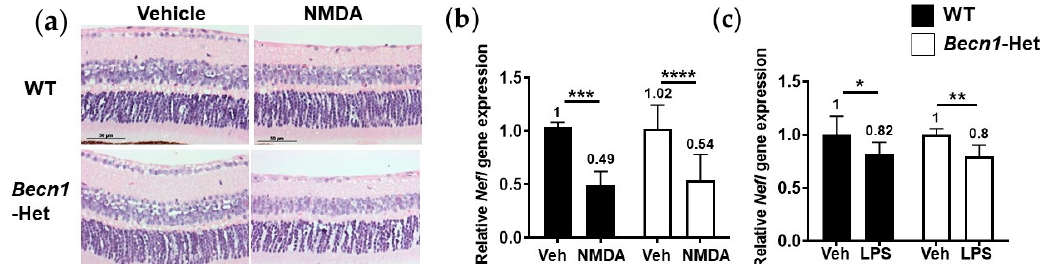
Figure 4. Beclin1-heterozygous mice ( Becn1 -Het) and wild-type (WT) mice are equally sensitive to excitotoxicity and neuroinflammation. Chemicals or their vehicle (Dulbecco’s phosphate buffered solution or D-PBS) were intravitreally injected into the eyes of WT and Becn1 -Het mice, and eyes were isolated 7 and 4 days post-injection for histological evaluation ( a ) and gene expression analysis ( b , c ), respectively. Quantitative PCR was performed for the neurofilament light chain ( Nefl ) gene. Each expression value was normalized to glyceraldehyde-3-phosphate dehydrogenase ( Gapdh) , the housekeeping gene, in individual samples and is shown relative to that obtained in the WT vehicle group. ( a ) Representative images of hematoxylin and eosin-stained retinae following intravitreal injection of 20 nmol/eye N-methyl-D-aspartate (NMDA) or its vehicle. ( b ) Effects of 20 nmol/eye NMDA or its vehicle on Nefl gene expression in the retina. N = 4 to 9 eyes from 2 to 5 mice for each group. ( c ) Effects of 2 µg/eye lipopolysaccharide (LPS) or its vehicle on Nefl gene expression in the retina. N = 6 to 9 eyes from 4 to 5 mice for each group. Each value represents the mean ± standard deviation with the mean value indicated at the top of each bar. For statistical analysis, a two-way analysis of variance was performed, followed by Sidak’s post hoc test * p < 0.05, ** p < 0.01, *** p < 0.001, **** p < 0.0001 for each pair of comparison.